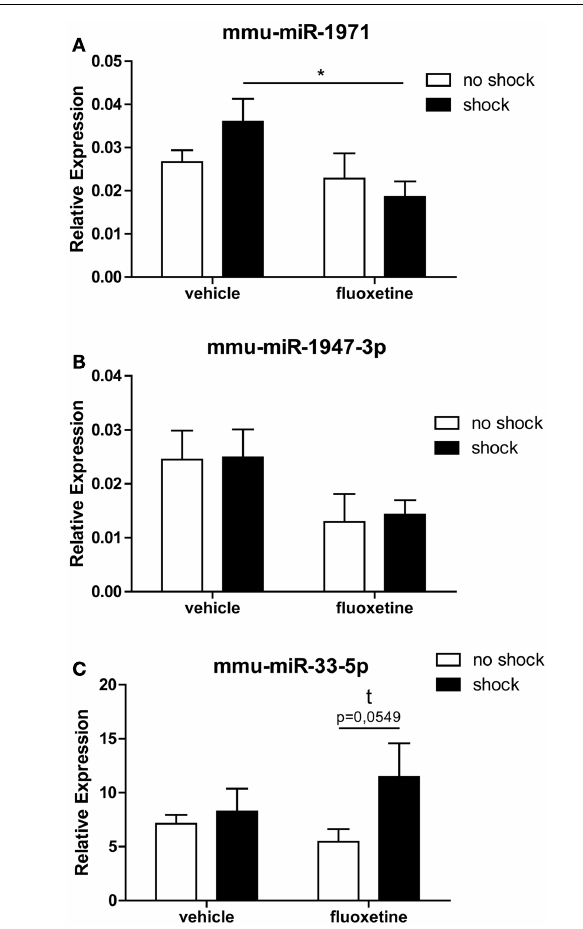
FIGURE 5 | RT-qPCR analysis confirmed that fluoxetine treatment alters the expression of mmu-miR-1971 and mmu-miR-33-5 in the PFC of shocked mice . Depicted are results of the RT-qPCR analysis of the relative expression levels of the candidate microRNAs mmu-miR-1971 (A) , mmu-miR-1947-3p (B) , and mmu-miR-33-5p (C) compared between the no-shock-vehicle, no-shock-fluoxetine, shock-vehicle, and shock-fluoxetine groups ( n = 6 per group). Prefrontal cortex (PFC) samples employed for RT-qPCR analyses were identical to those used for microarray analyses. Mmu-miR-100-5p was used for normalization using the ∆∆ C t method. Presented data are means ± SEM. Statistical analysis was performed using two-way ANOVA and Bonferroni post hoc tests. Statistical significance of Bonferroni post hoc tests is indicated by * p < 0.05. See Section “Results”